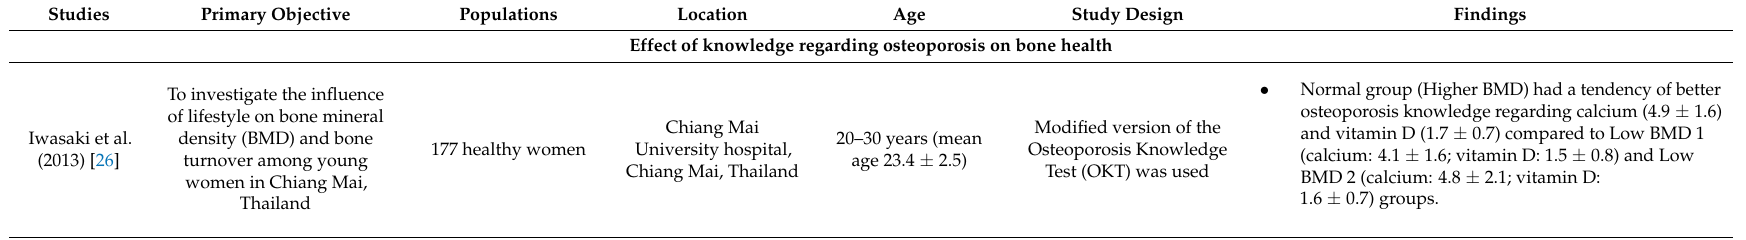
Table 4. Relationship between knowledge of osteoporosis, lifestyle and dietary habits with bone health among adolescents and young